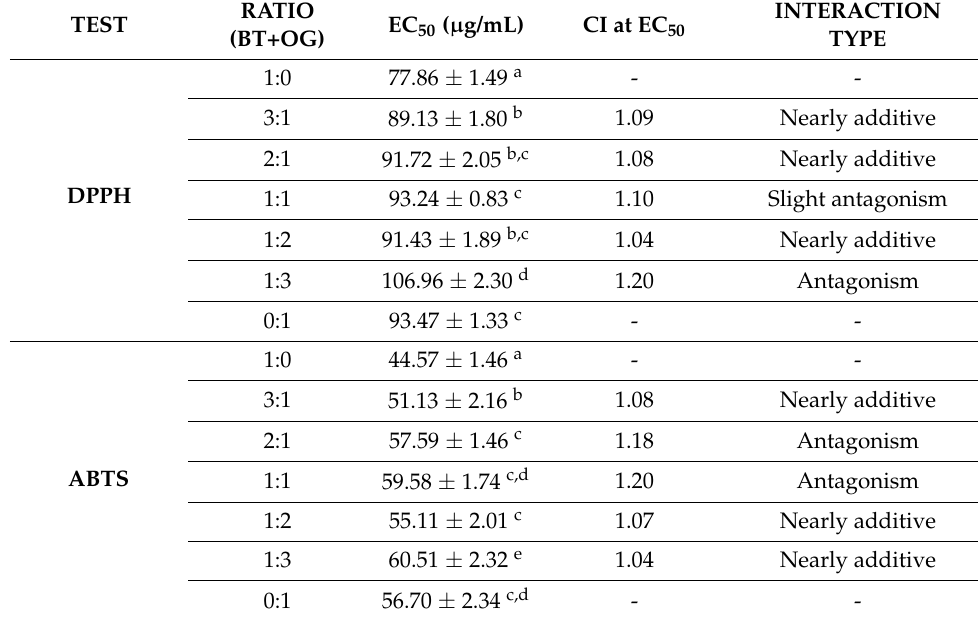
Table 1. The EC 50 , combination index, and type of antioxidant interactions of black tea and O. gratissimum combination for antioxidant